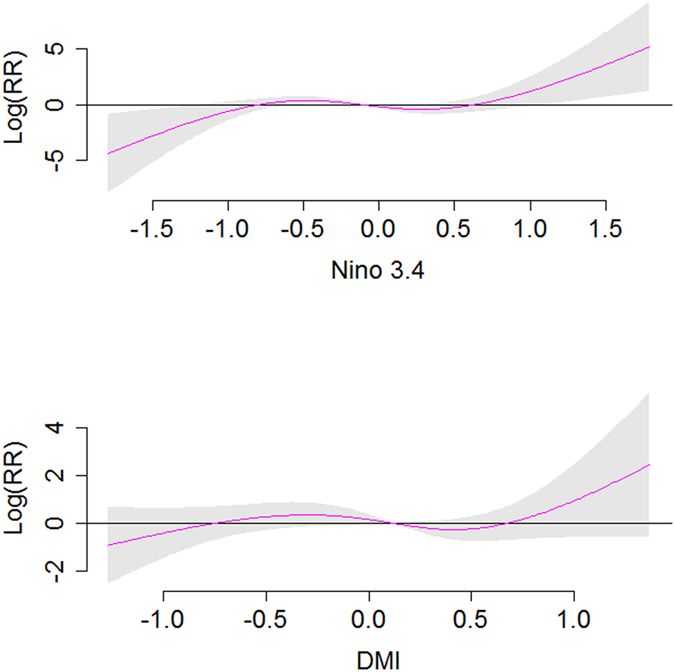
Estimated overall effects of ENSO/ IOD on dengue incidence rate after adjustment of potential confounders.The centre line in each graph represents the estimated spline curve, and the shadow represents 95% CI.